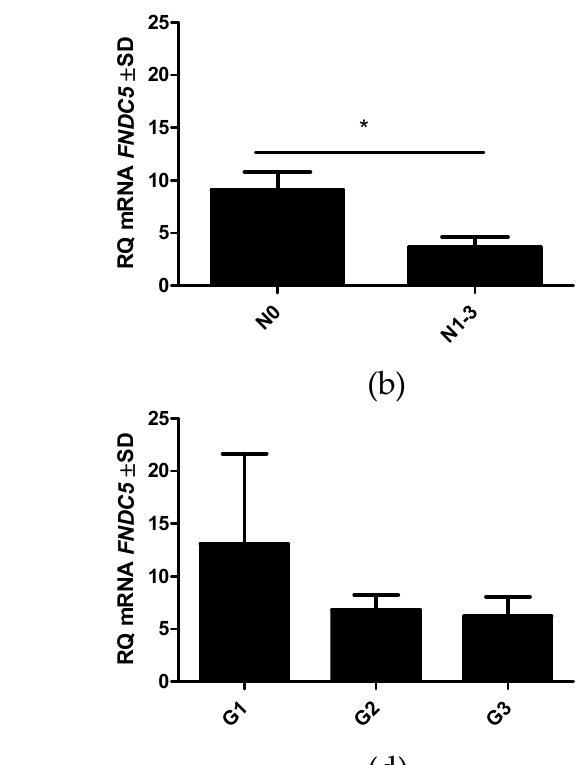
Figure 6. FNDC5 gene expression in NMBD samples, breast cancer (BC) cells, and BC tumor margin. *** p < 0.001.